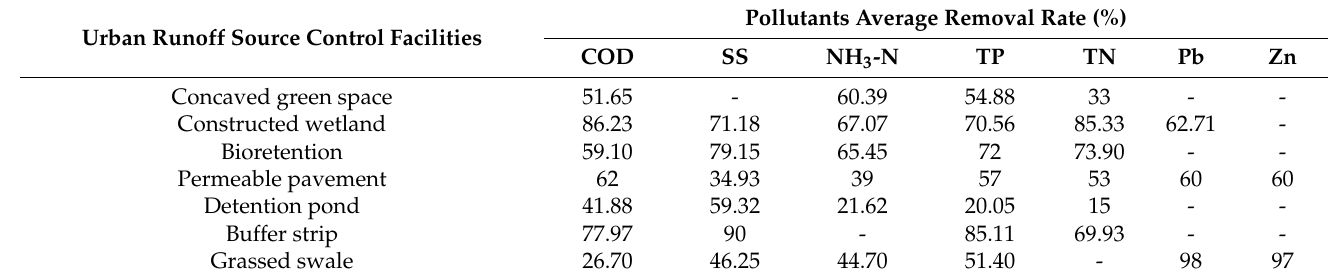
Table 1. Pollutants average removal rate of urban runoff source control facilities (reprinted with permission from Ref. [51]. 2020, Changqing